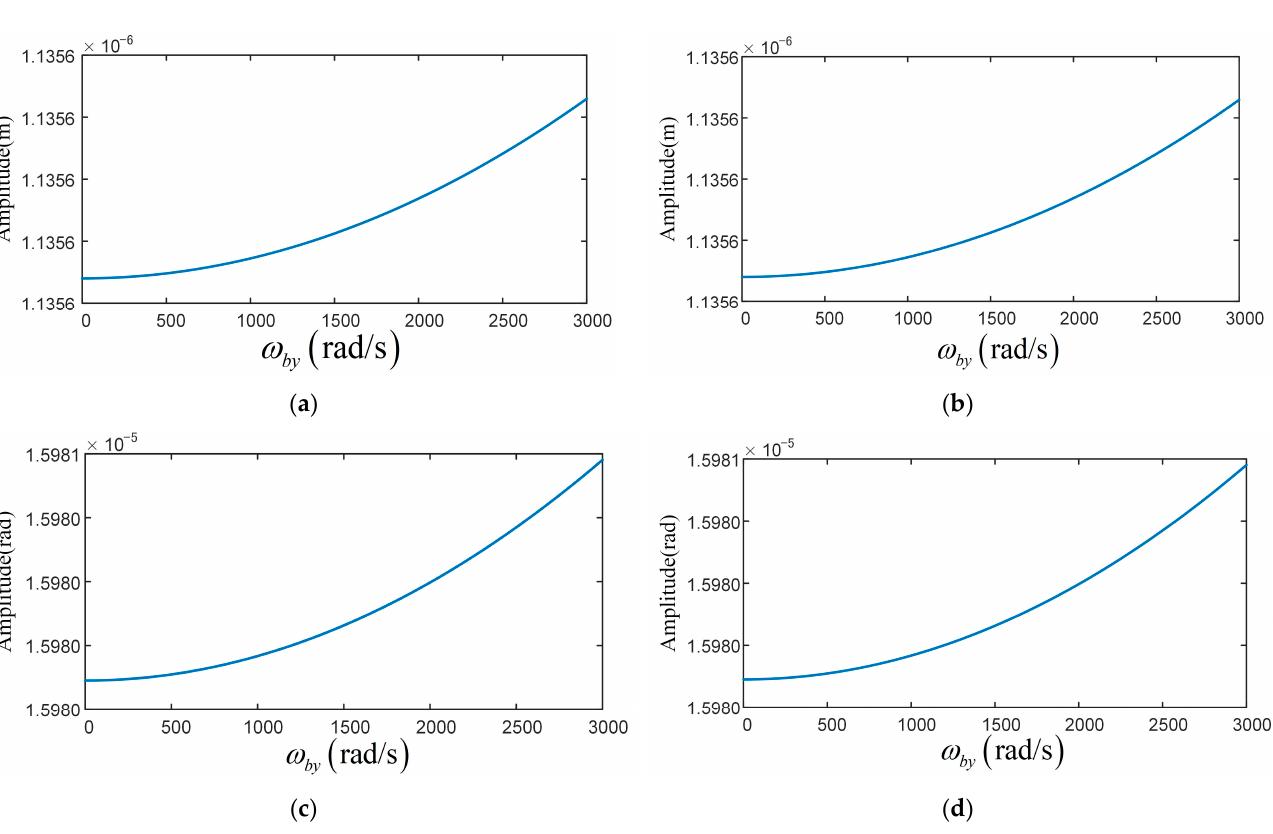
Figure 11. Responses of the dual-rotor system at disk 1 due to gravity with pitching base motion: